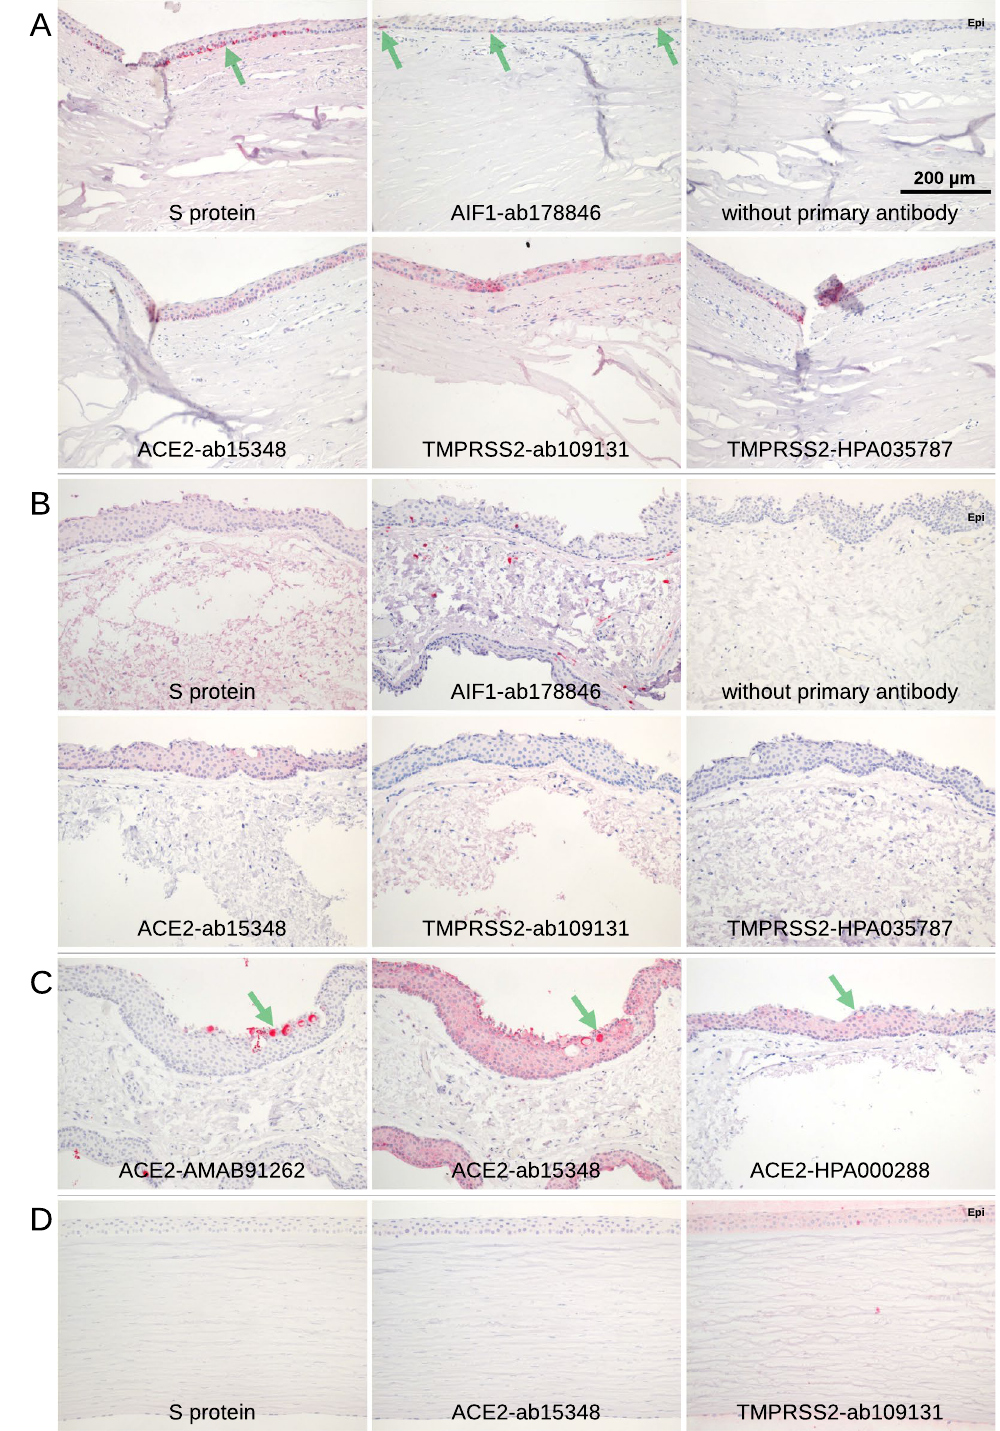
Figure 2. Conjunctiva and cornea. Immunohistochemical staining of serial paraffin sections. ( A ) Staining (red) of the basal part of the epithelium of limbal conjunctiva was observed in a single specimen (green arrows). The staining was very distinctive with S protein but less distinctive for the TMPRSS2-HPA035787 antibody while ACE2-ab15348 and TMPRSS2-ab109131 showed a broader pattern over the whole thickness of the epithelium. The staining was restricted to the area shown and not found at the other side of the cornea. Staining for AIF1 showed a comparable pattern indicating that the cells are macrophages. ( B ) Conjunctiva. S protein is overstained with uniform staining of every tissue. The epithelium (Epi) may be stained with antibody ACE2-ab15348. Red staining for AIF1 showed some epithelial and sub-epithelial macrophages. ( C ) Staining of goblet cells was found at single sites of some of the conjunctival specimen with antibodies raised against ACE2 only (green arrows). ACE2-ab15348 showed an additional staining in the epithelium. ( D ) Only background staining was observed by S protein and antibodies for ACE2 and TMPRSS2 in cornea. Epithelium